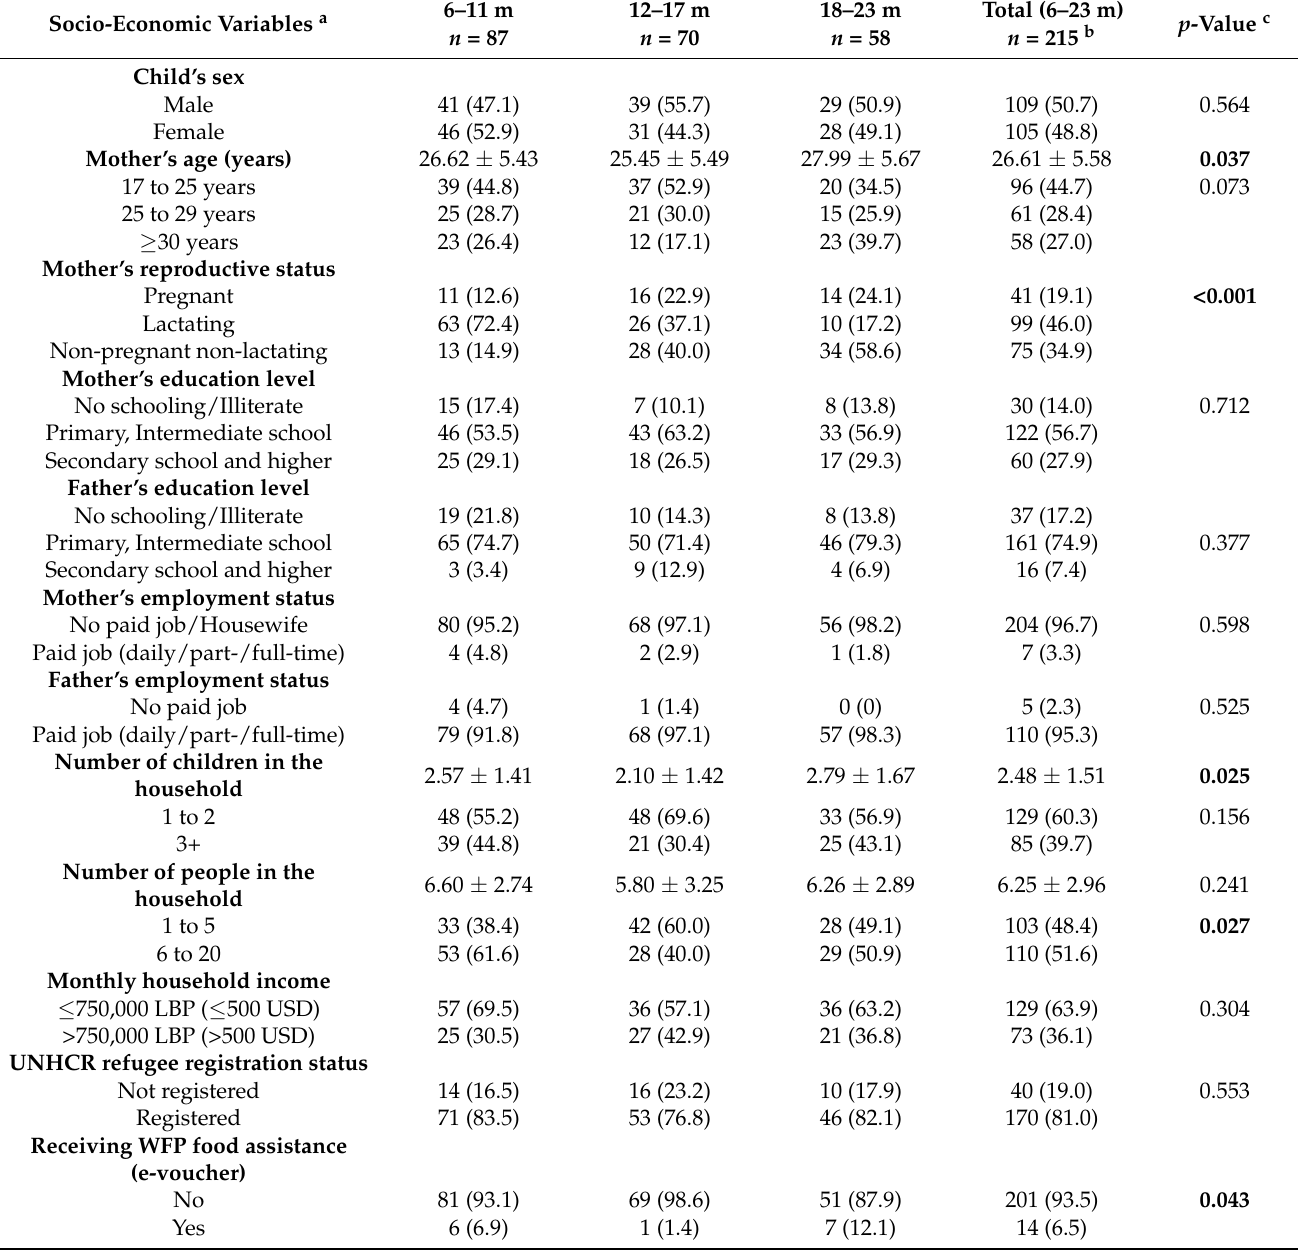
Table 1. Socio-economic status of Syrian refugee children aged 6 to 23